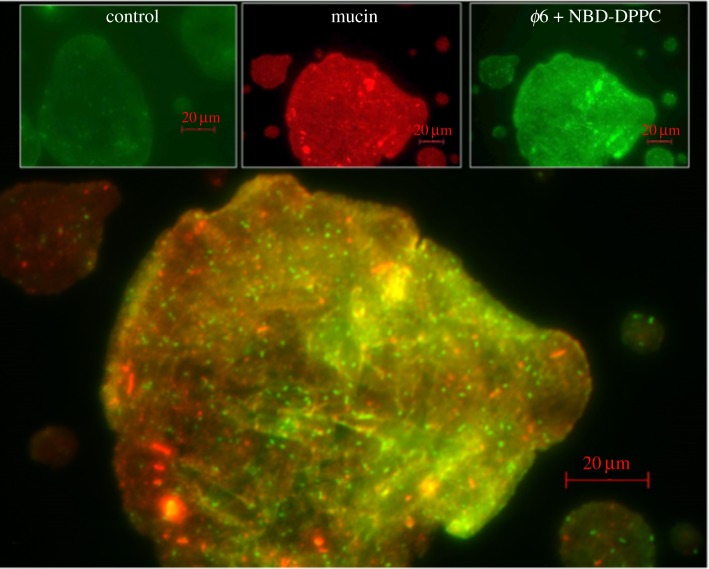
Composite fluorescent image of a 4C droplet containing ϕ6 virus exposed to 29% RH. The bright green dots approximately 1 µm in size may indicate the location of the virus. All scale bars are 20 µm.